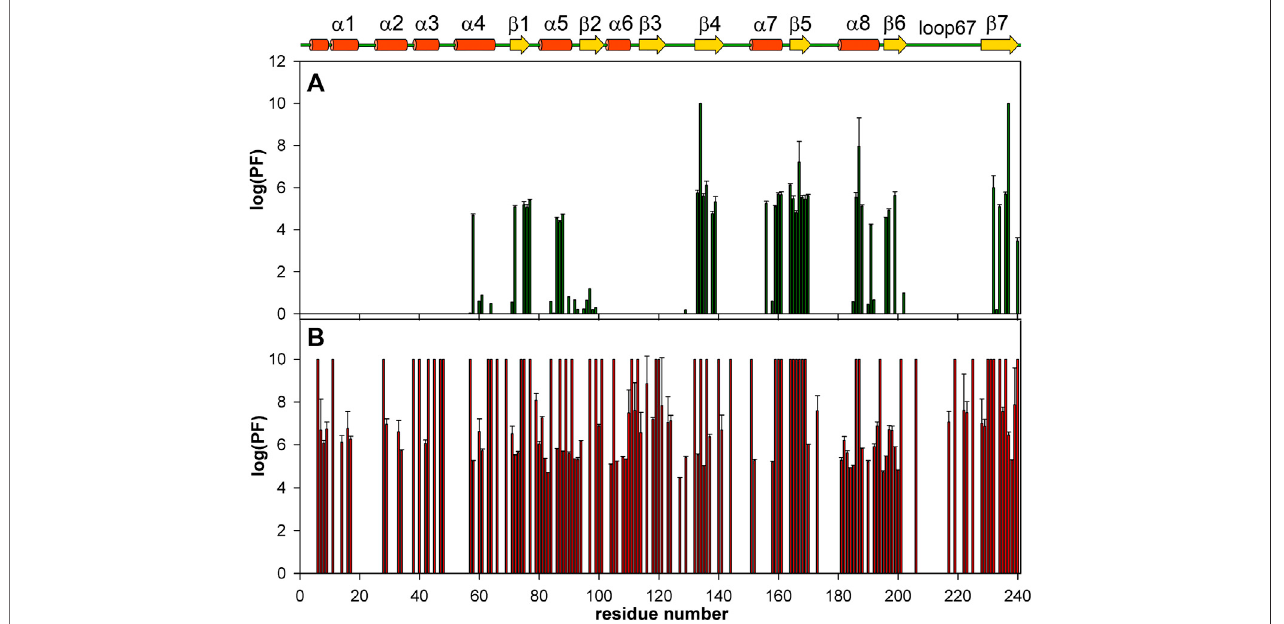
FIGURE 7 | Bar charts showing the amide HN protection factors of the apo-WBSCR27 (A) and complex WBSCR27-SAH (B) . The elements of protein secondary structure identi fi ed for WBSCR27-SAH solution structure are shown on the top.